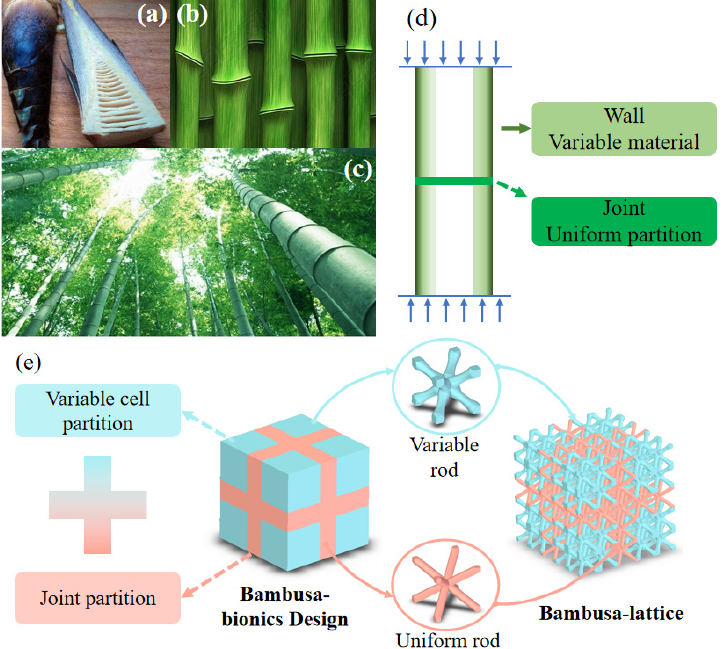
Figure 2. Bambusa-lattice structure inspired by bambusa joints and gradient tube walls: ( a – d ) Bam- busa joint and tube structures; and ( e ) Bambusa bionic